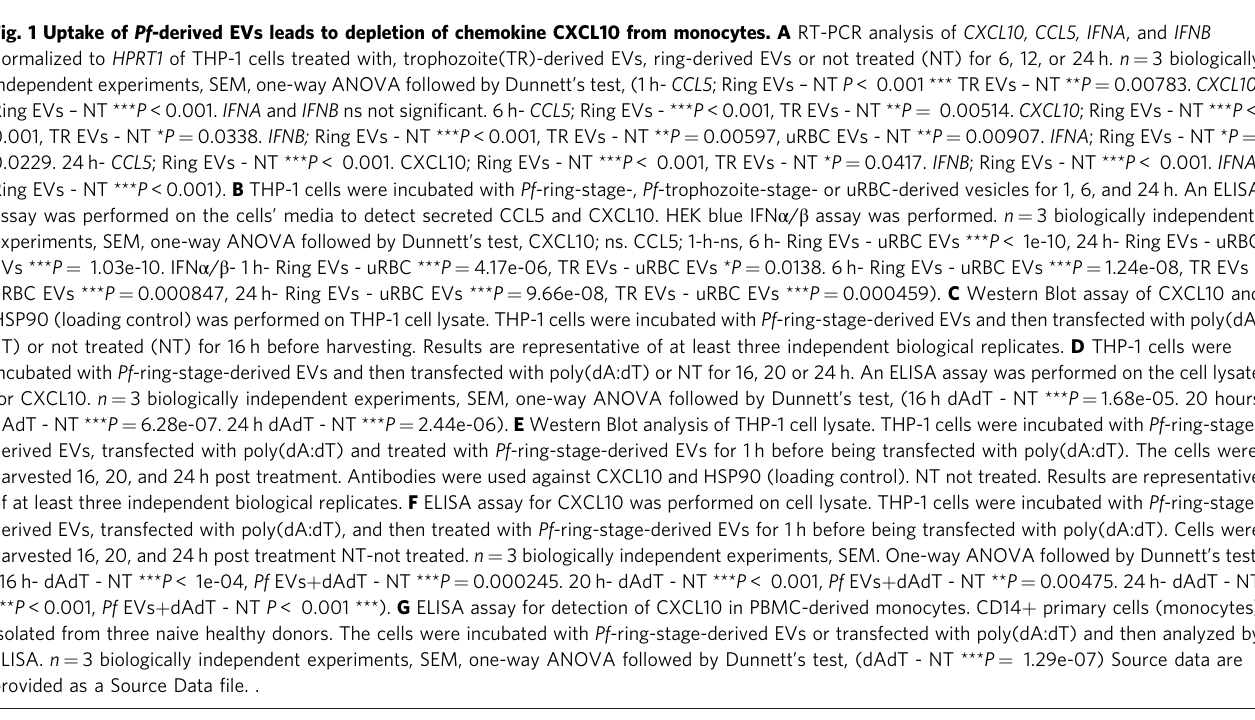
Fig. 1 Uptake of Pf -derived EVs leads to depletion of chemokine CXCL10 from monocytes. A RT-PCR analysis of CXCL10, CCL5, IFNA , and IFNB normalized to HPRT1 of THP-1 cells treated with, trophozoite(TR)-derived EVs, ring-derived EVs or not treated (NT) for 6, 12, or 24 h. n = 3